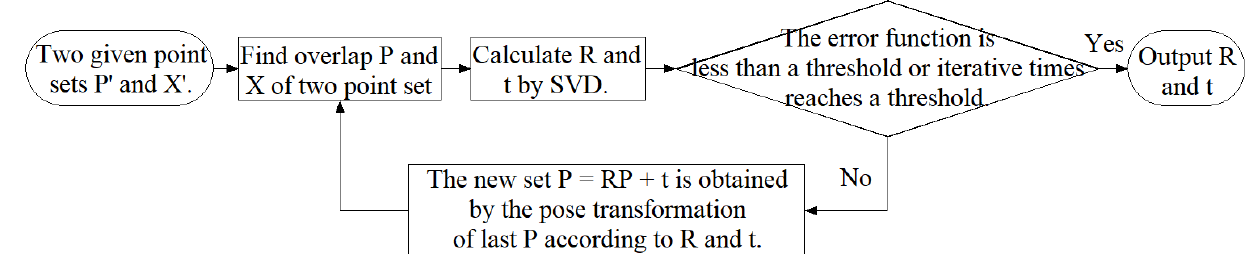
Figure 3. Flow chart of the ICP algorithm.